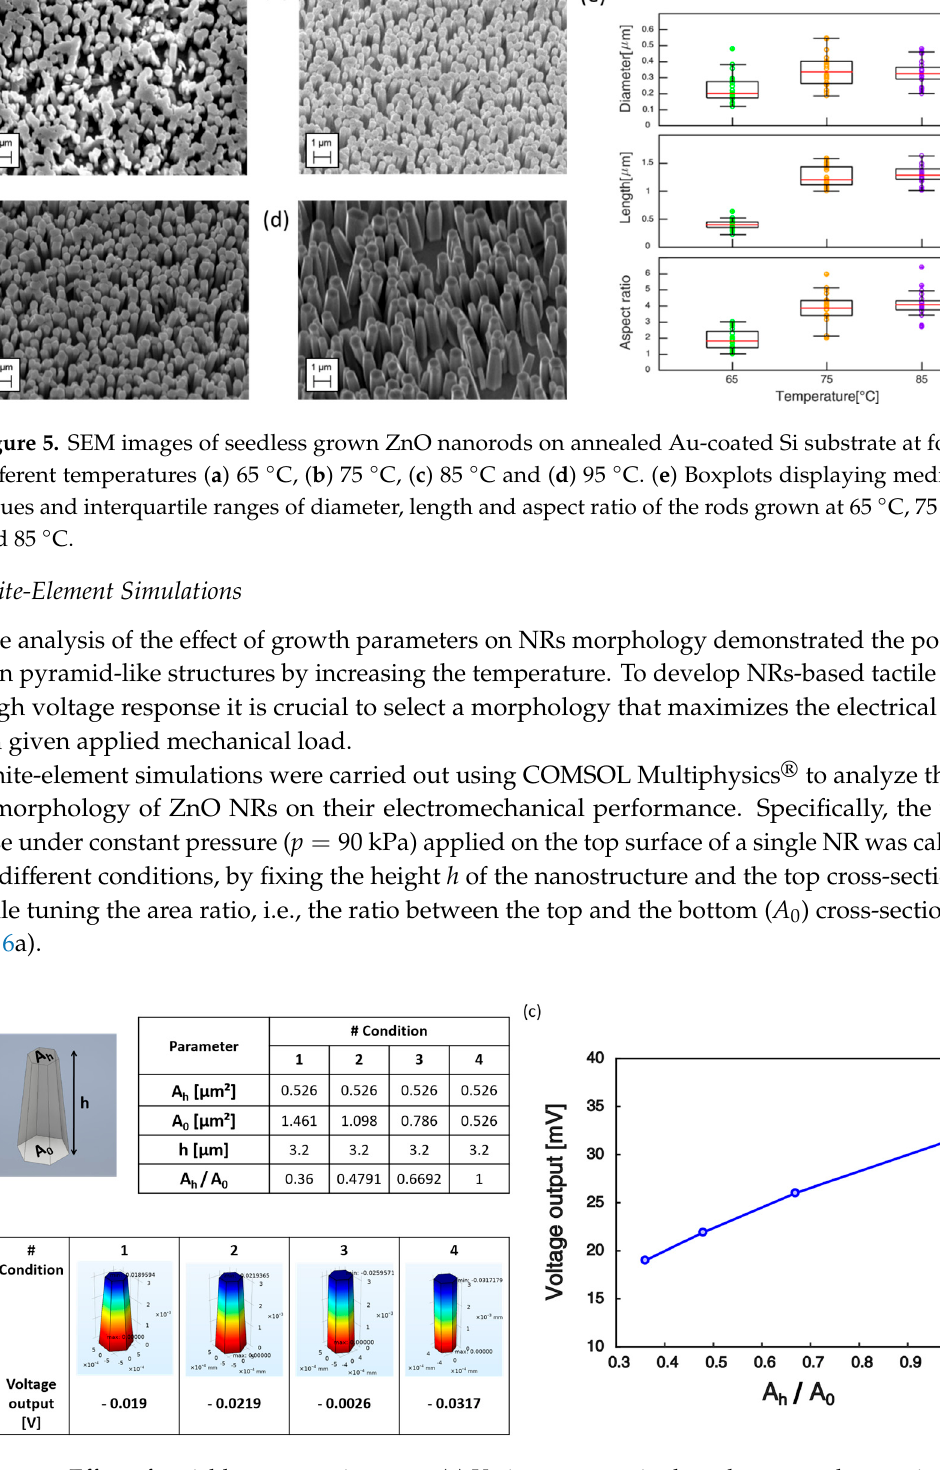
Figure 6. Effect of variable cross-section area. ( a ) Various geometries have been tested numerically corresponding to di ff erent area ratios ( A h / A 0 ). ( b ) Electric potential generated under pressure of 90 kPa applied on top of the NR. ( c ) The voltage output (absolute value) of the numerical model increases as the NR morphology changes from pyramid-like to hexagonal prismatic.